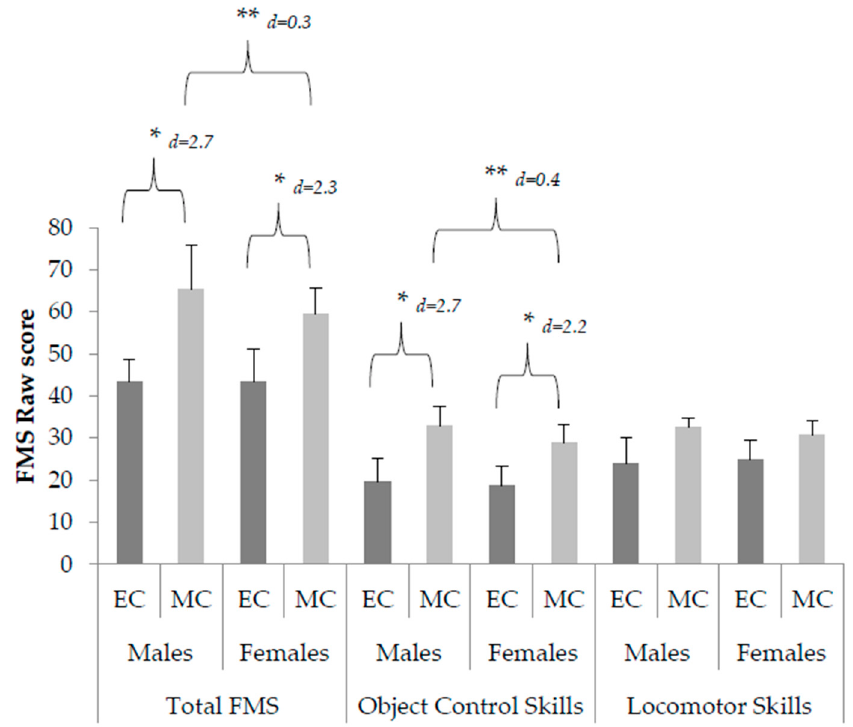
Figure 1. Total Fundamental Motor Skills and object control skill proficiency scores (mean ± standard deviation) of males and females in early and middle-childhood. * Indicates significant difference between age groups ( p < 0.05). ** Indicates significant difference between males and females in middle-childhood ( p < 0.05).